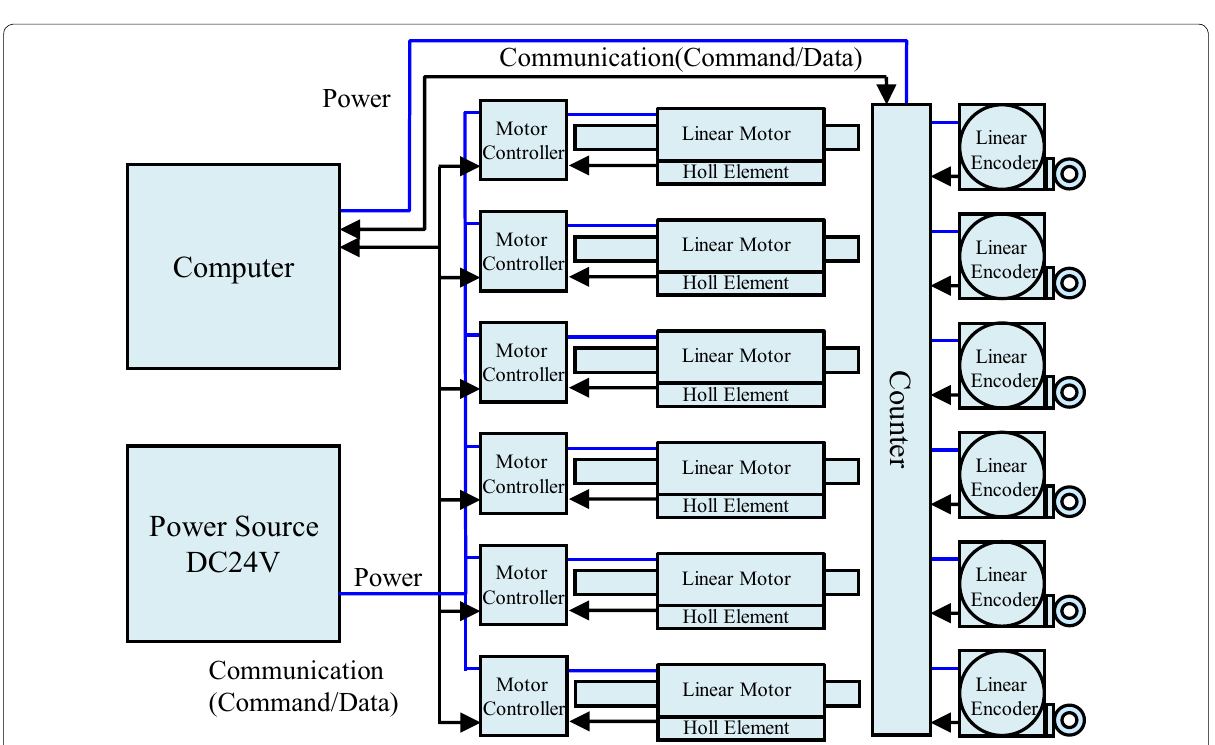
Fig. 3 System chart of a developed device